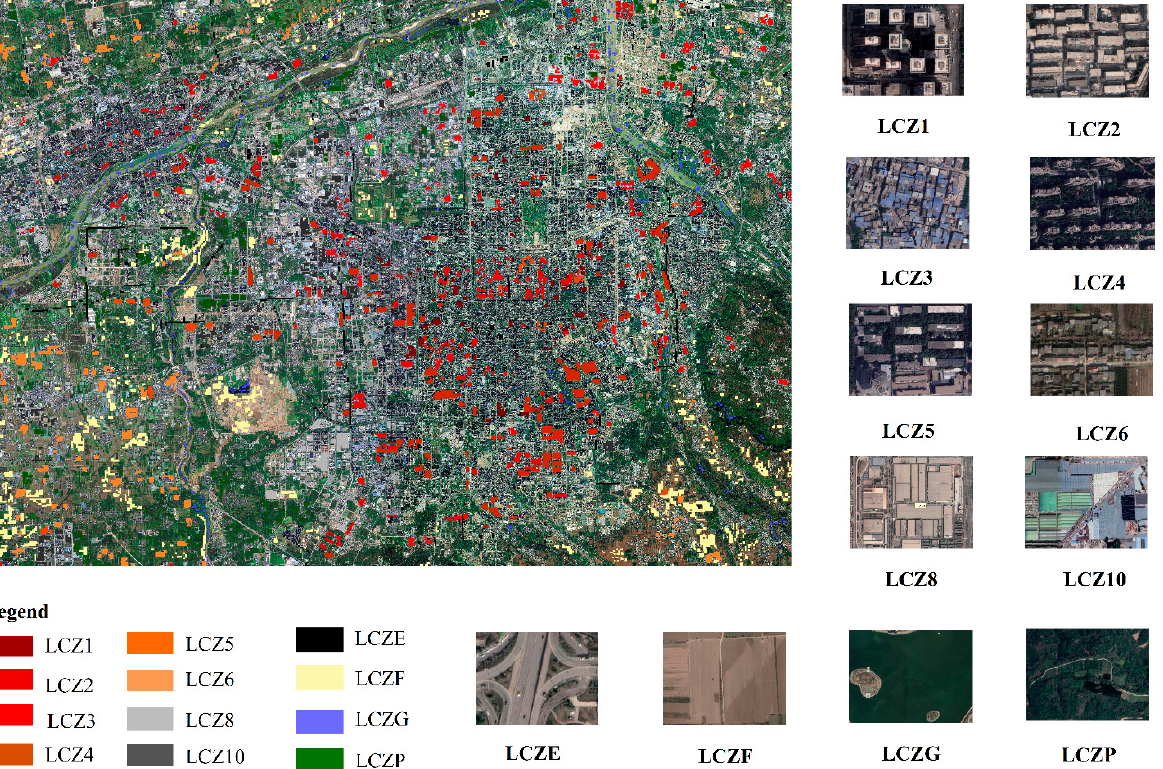
Figure 2. GF-6 images and LCZ labels outlined in Google Earth; schematic diagrams of Google Earth images for each category of LCZ are shown on the right, including but not limited to the above examples.